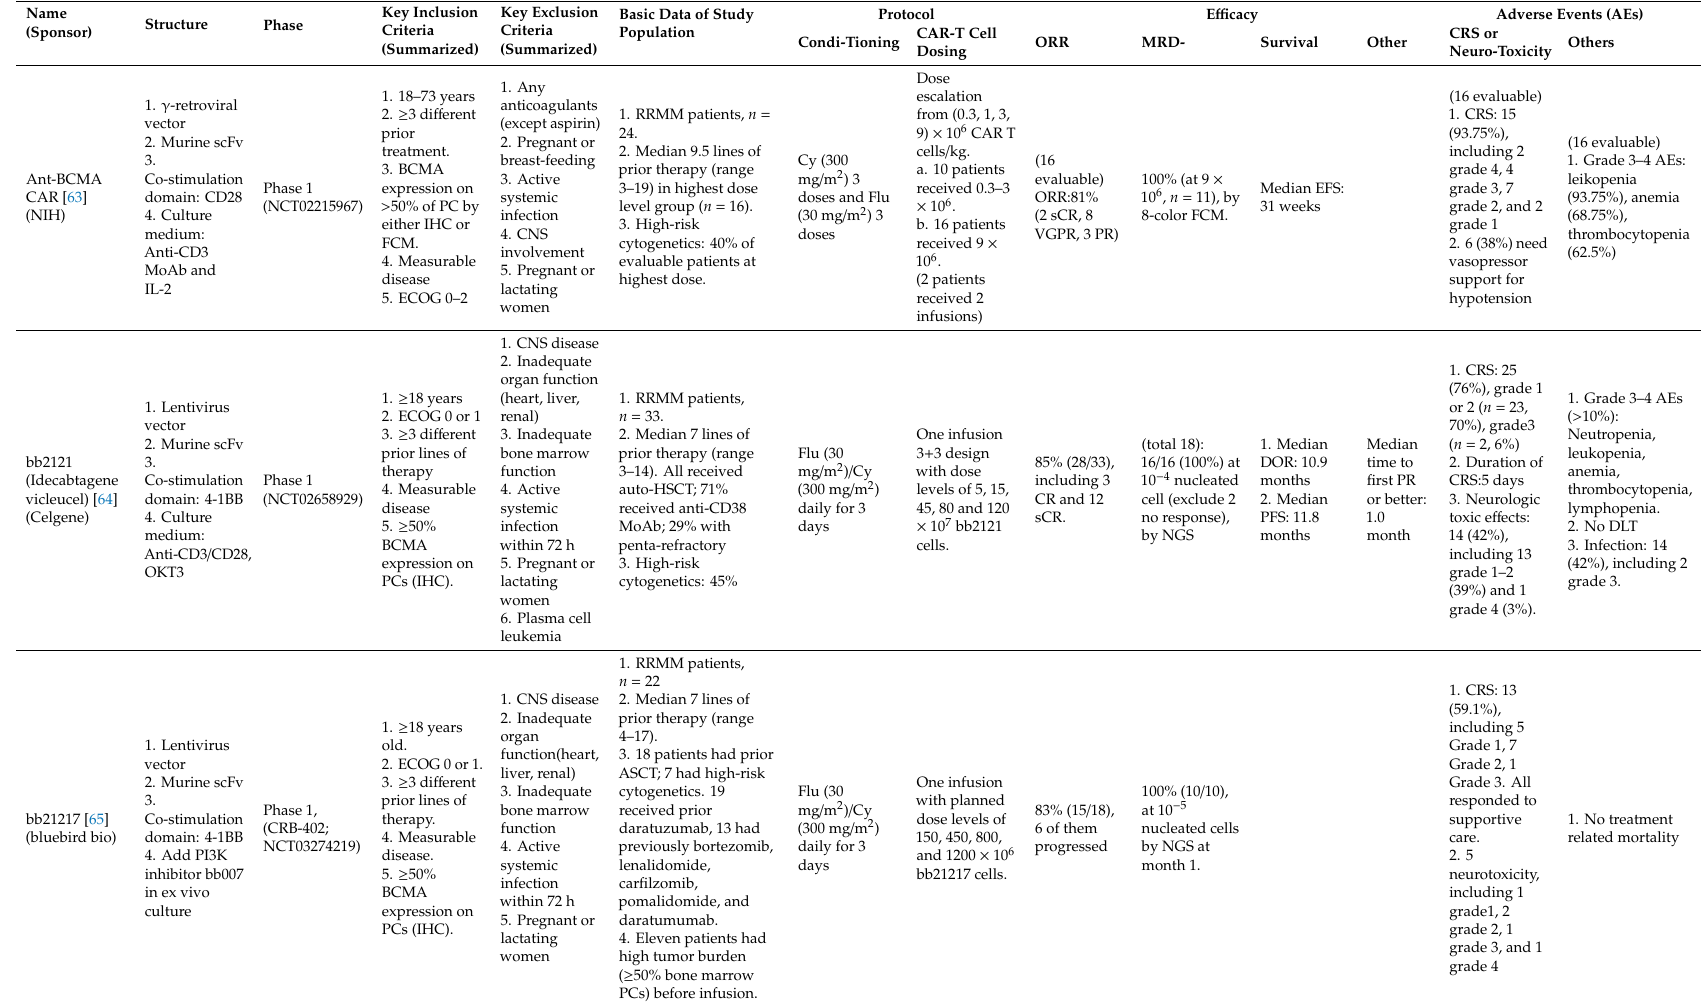
Table 1. Summary of early phase clinical trials of anti-BCMA CAR T-cell